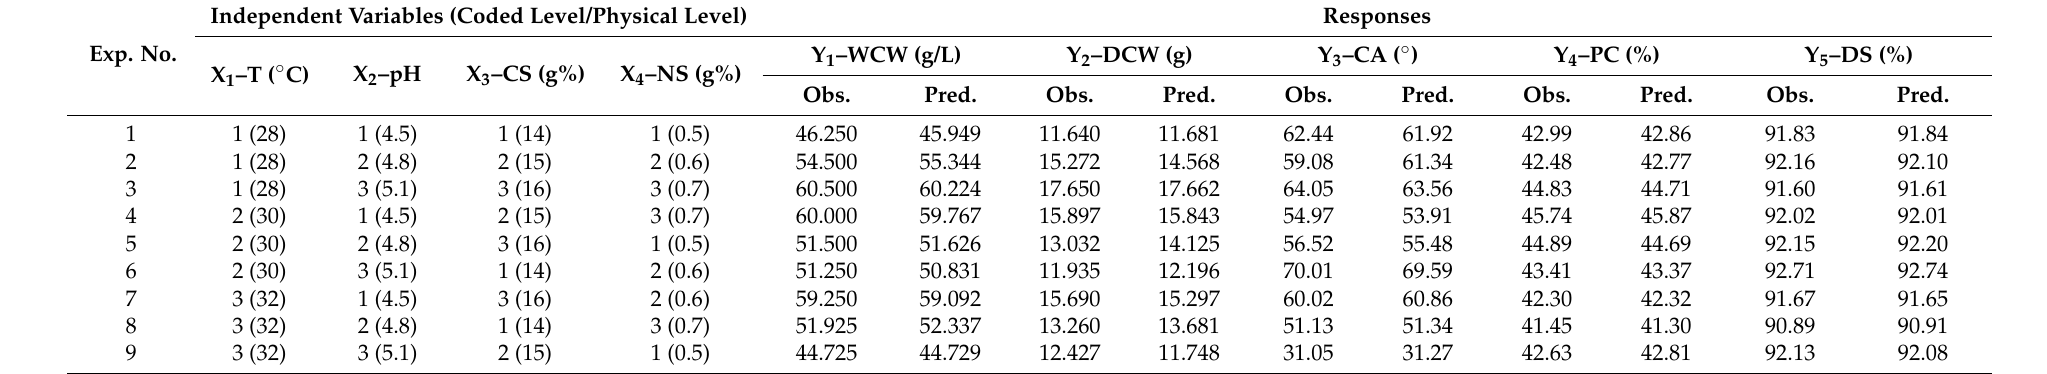
Table 3. Fractional experiment matrix 3 4 —coded and physical independent variable values; the observed and predicted responses of the various parameters obtained by brewing yeast biotechnological